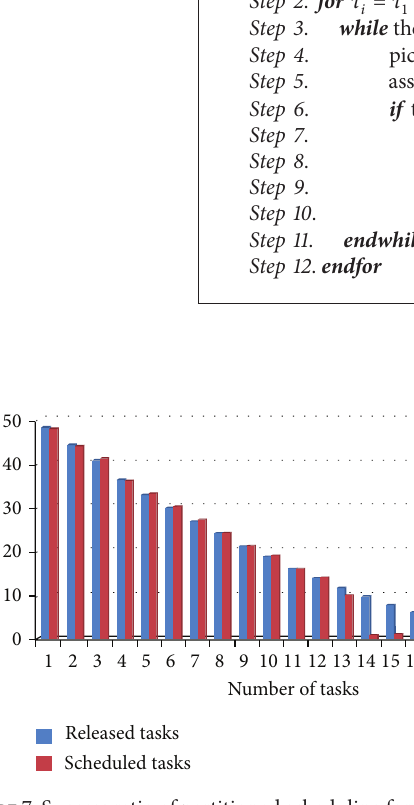
Figure 7: Success ratio of partitioned scheduling for the system load 2.94.